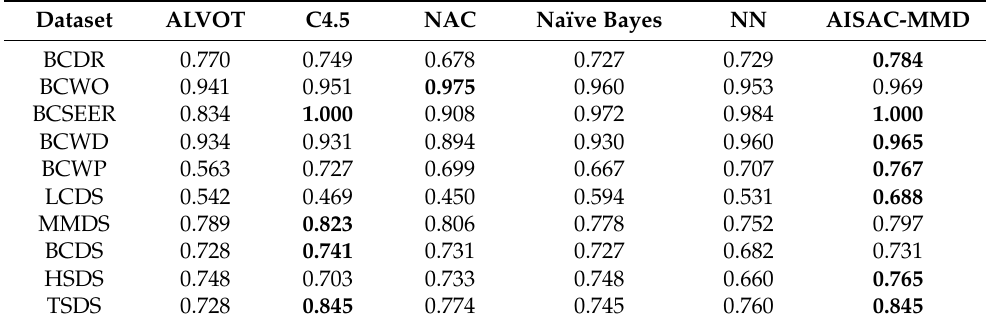
Table 3. Balanced accuracy results for classifiers dealing with mixed and incomplete data.